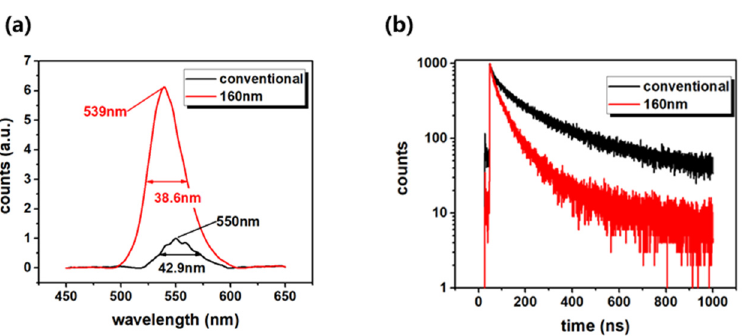
Figure 4. ( a ) PL spectra at room temperature, ( b ) TRPL spectra at 77 K of conventional and nano samples.